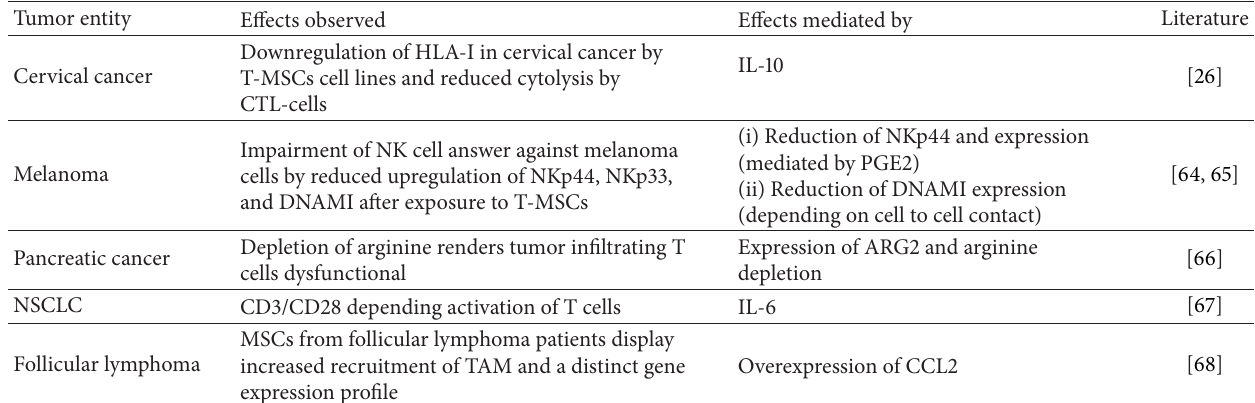
Table 3: Immunomodulation by MSCs and